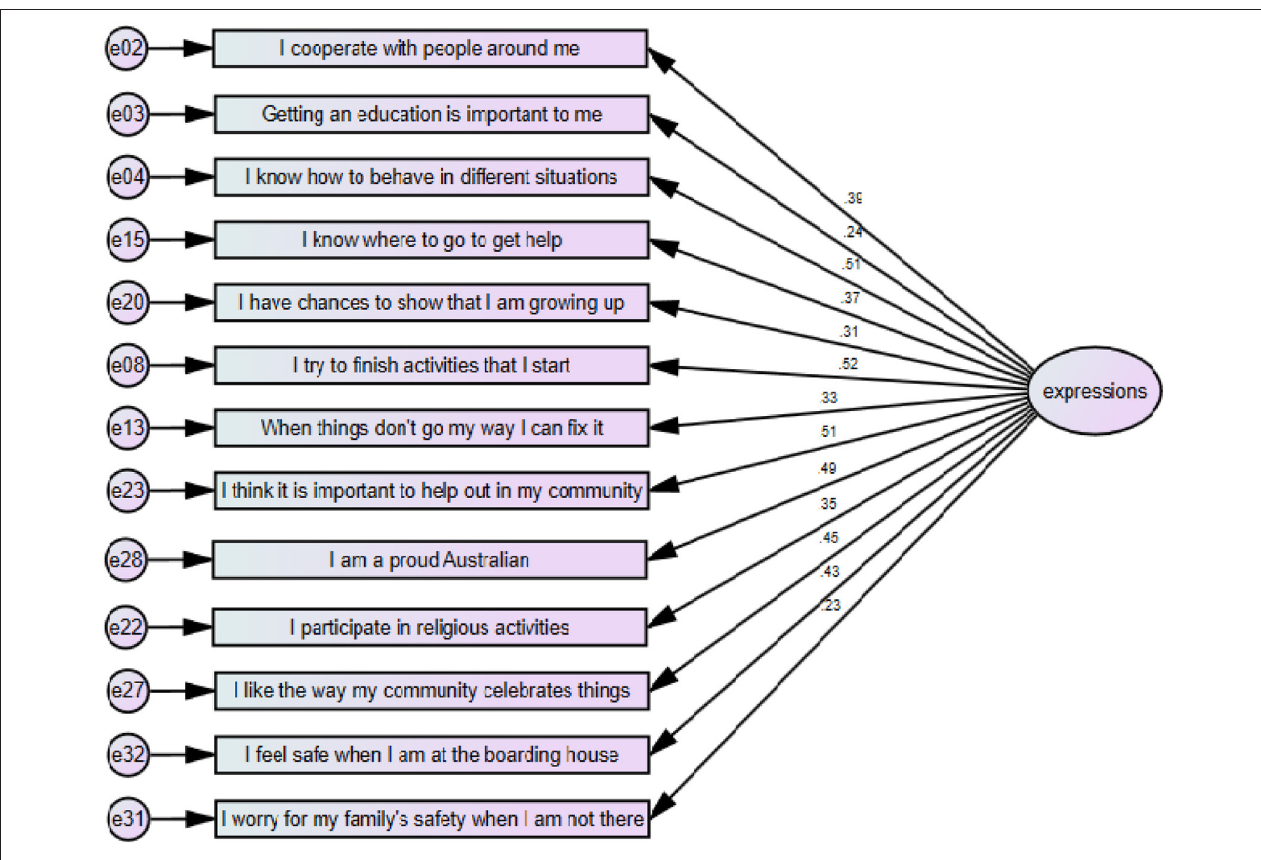
FIGURE 2 | Expressions of Resilience including standardized item loadings.